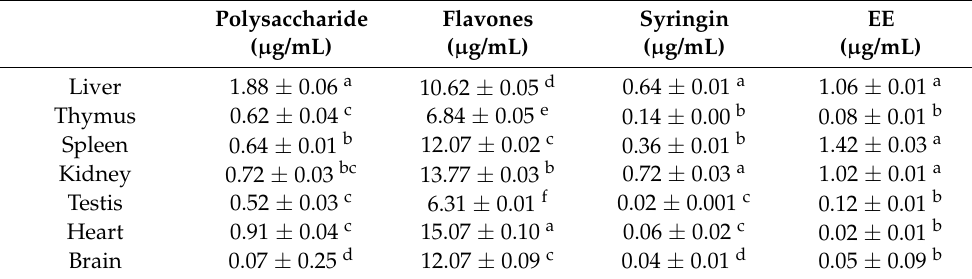
Table 1. The content of functional components of AS in tissues (ug/mL).